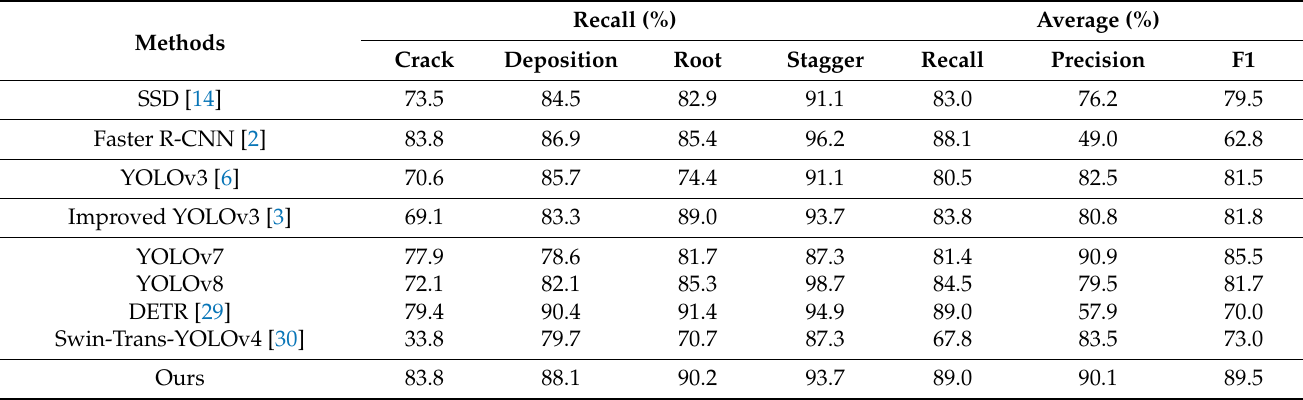
Table 7. Recall, Precision and F1 values of different models on the test